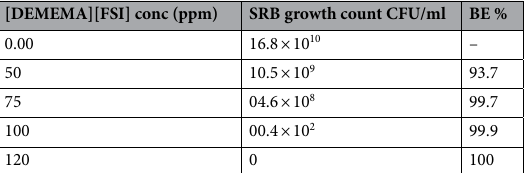
[DEMEMA][FSI] conc (ppm) SRB growth count CFU/ml BE